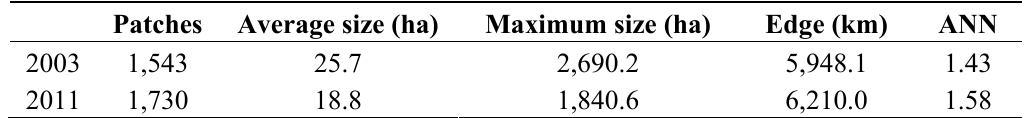
Table 4. Comparison of fragmentation indicators of European dry heaths mapped in the SCI Os Ancares–O Courel during the period